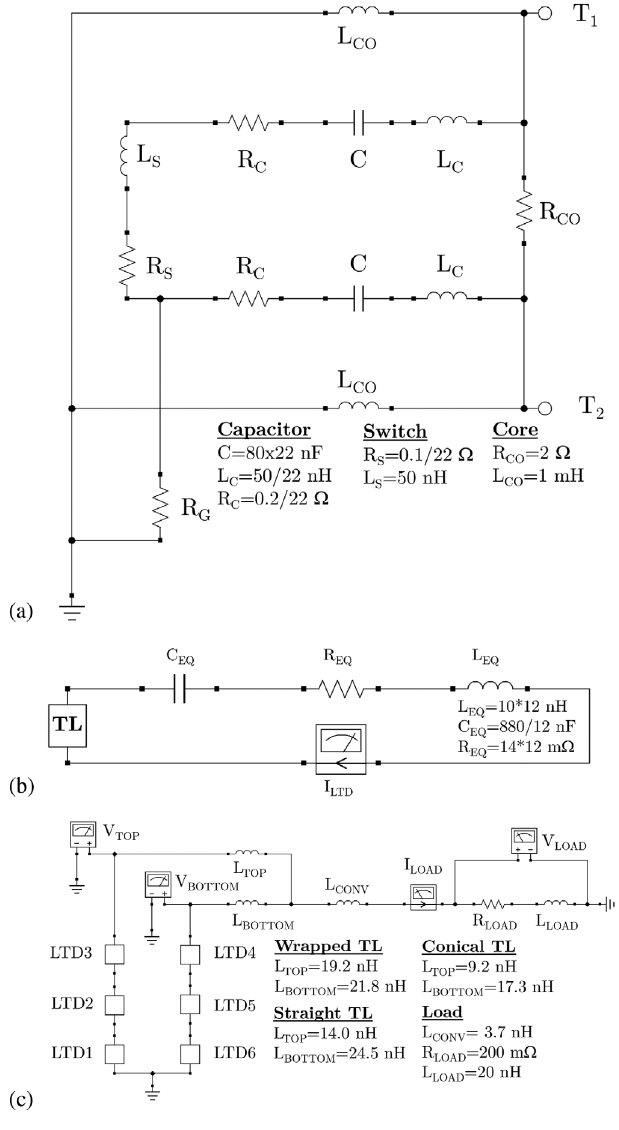
FIG. 4. (a) Equivalent RLC circuit for one cavity with 22 bricks used in SPICE simulations. T 1 and T 2 are the terminals used to connect one cavity to the next. R G is a 5 M Ω resistor, stabilizing the numerics. (b) Equivalent RLC circuit for one cavity used in COMSOL simulations. TL indicates the connection the trans- mission lines at a given height. (c) HADES equivalent RLC circuit. Each block (LTD1-6) uses the subcircuit shown in (a). The volt and amp meters are measuring the top (TOP) and bottom (BOTTOM) modules as well as the load (LOAD) voltages and current. The post-hole convolute inductance ( L ) was kept CONV constant in all three